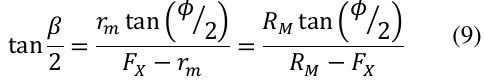
=30 mm and Y and R radii m M